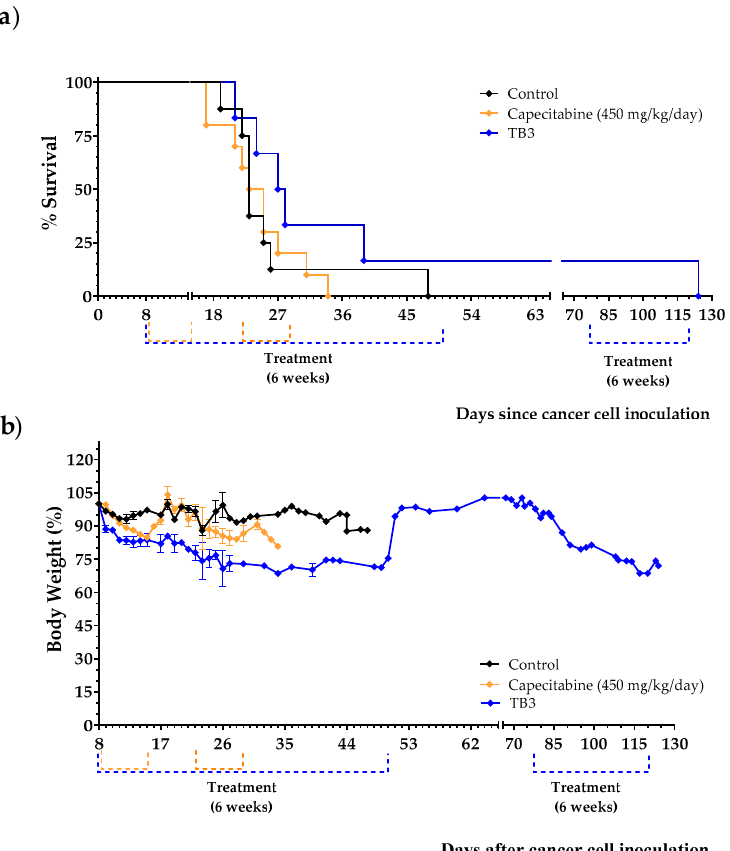
Figure 6. Anticancer activity of diet TB3 and capecitabine in mice with metastatic TNBC. ( a ) Sur- vival of mice treated with diet TB3 (normal diet was replaced with this diet), or oral